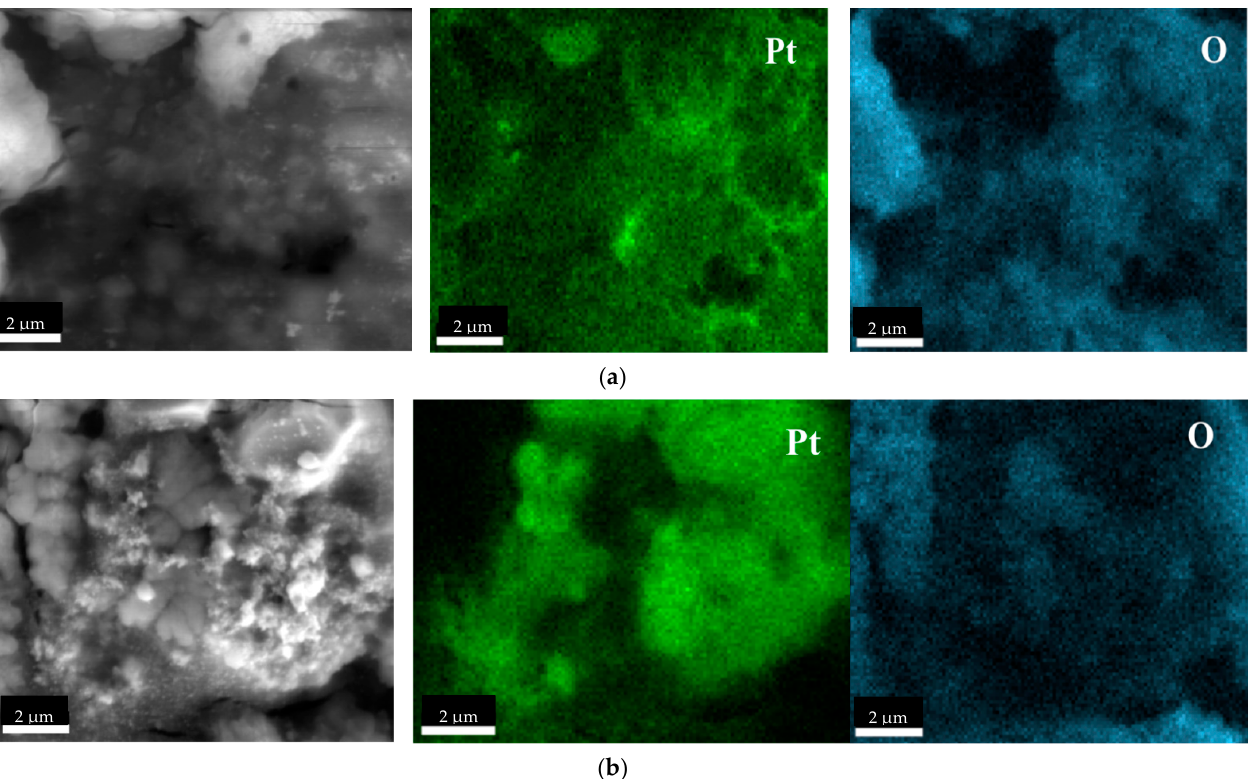
Figure 5. Scanning electron microscopy (SEM) coupled with EDS images of Pt-NP (the molar ratio of PGM:PVP:reducer was 1:5:2) using ( a ) AA and ( b ) NaBH 4 .